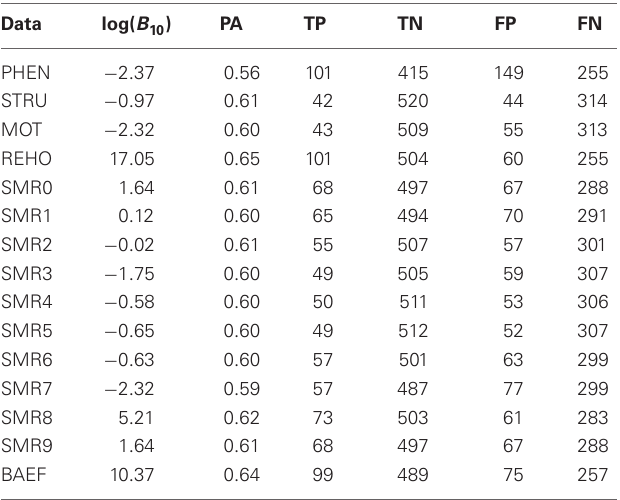
Table 6 | Multi source